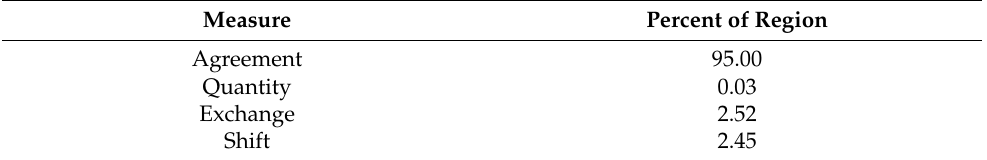
Table 5. Agreement and components of disagreement between reference NLCD 2016 and FORE-SCE modeled output for the same year and land cover categories for the